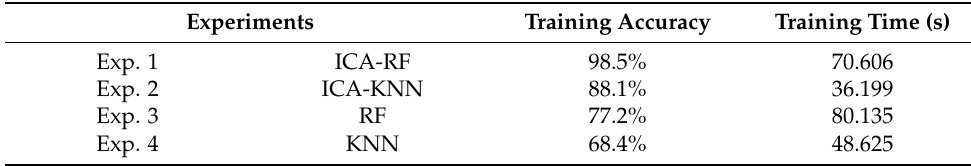
Table 3. The Results of Model